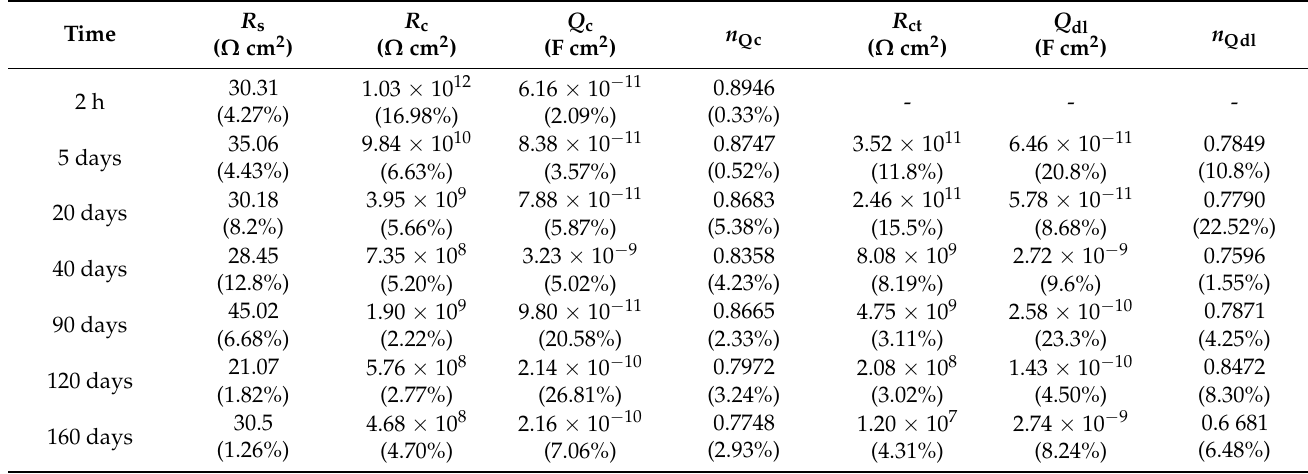
Table 2. The impedance fitting parameters of the FW-1 coating sample.